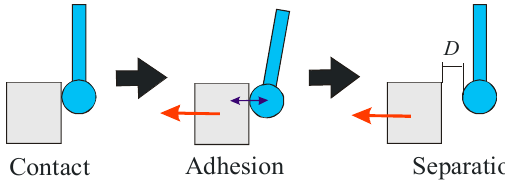
Figure 9. Experimental apparatus for measurement of surface force.